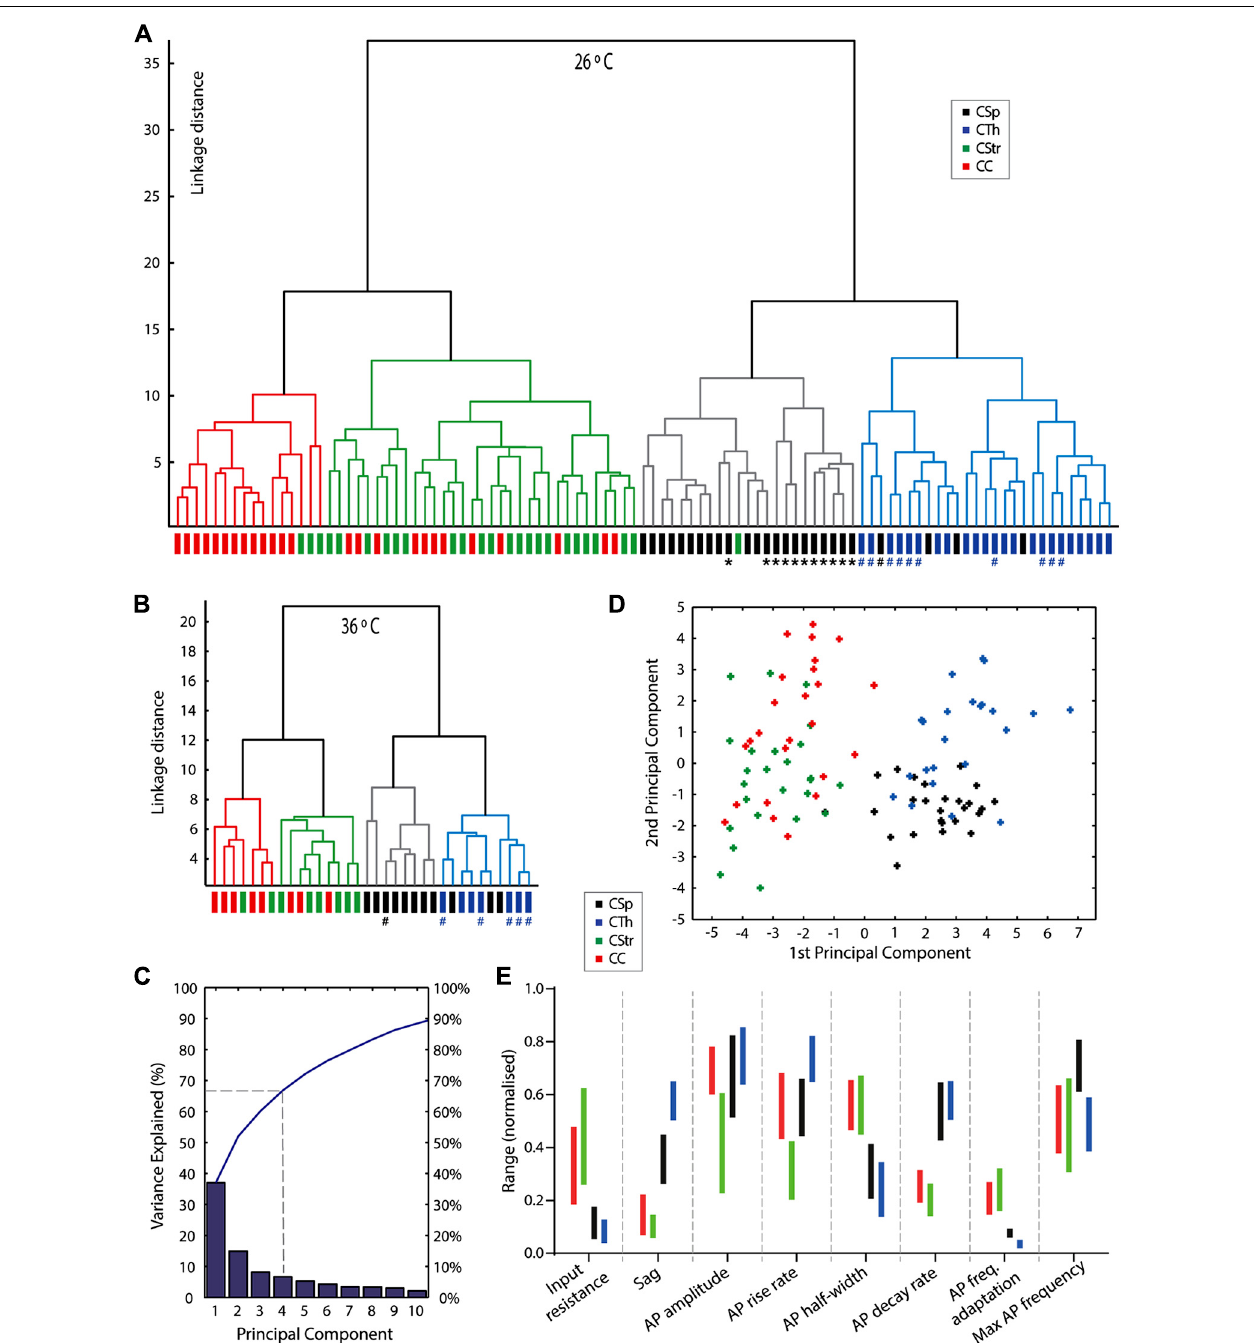
lumbar spinal cord are marked with an asterisk *. (C) Graph of the variances explained by the first ten components from a princial component analysis of the 26 ◦ C data.The blue line shows the cumulative variance. (D) Plot of scores for each cell from the first two principal components (CSp, black; CTh, blue; CStr, green; CC, red). See also Table 4 . (E) Non-overlapping interquartile ranges (vertical bars colored to represent cell type) of electrophysiological parameters for each cell type helps provide an indication of the key parameter differences for the different projection neuron types.The data is normalized to the absolute range (min to max, zero to one) of all values encountered for each parameter from the different groups of